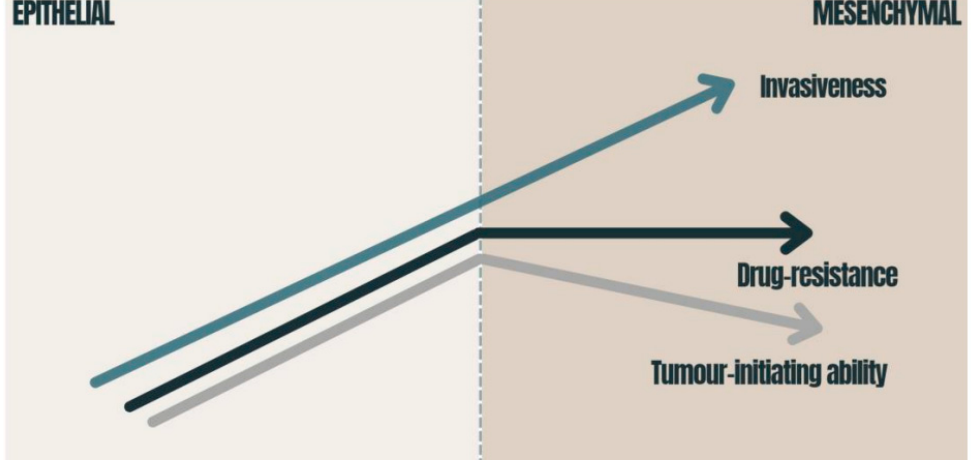
Figure 2. Consequences of EMT in carcinomas: the graphic presents how the tumor-initiating ability, invasiveness and degree of chemoresistance change during EMT activation. The tumor-initiating ability is affected by the degree of EMT activation; immense EMT activation has a deleterious effect on the tumor-initiating ability [40]. Drug resistance is also related to EMT and reaches its maximum at an intermediate level of EMT activation [40,41]. The migration of cancer cells requires the strong activation of the EMT program [42]. EMT—epithelial-to-mesenchymal transition.